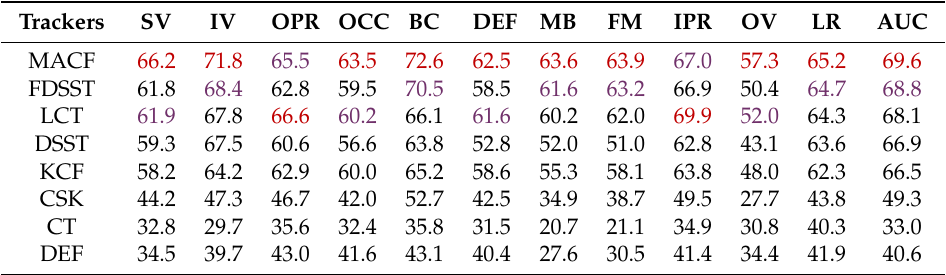
Table 5. Success plots of Spatial Robustness Evaluation (SRE) for the MACF and the other 7 top trackers on different attributes: SV, IV, OPR, OCC, BC, DEF, MB, FM, IPR, OV, and LR. The last column is the AUC. The best results are in red and the second results are in blue. Trackers